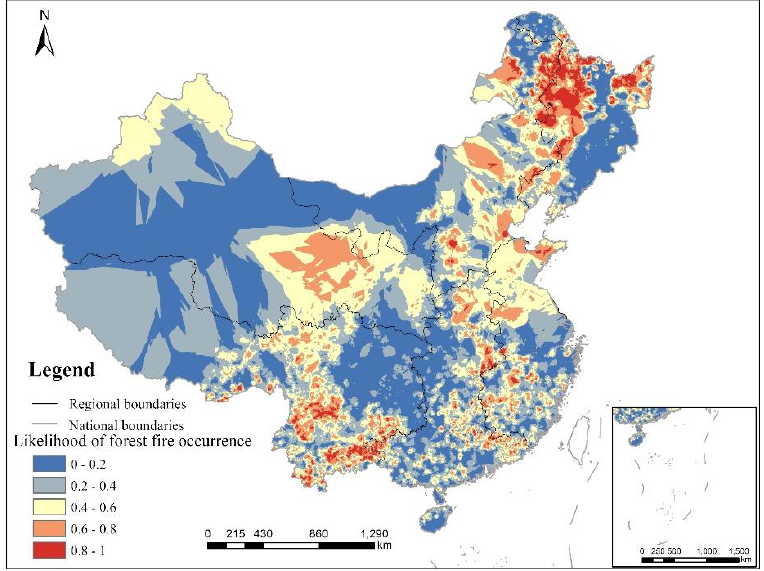
Figure 6. Map of the likelihood of forest fire occurrence in China obtained from the whole study area model.